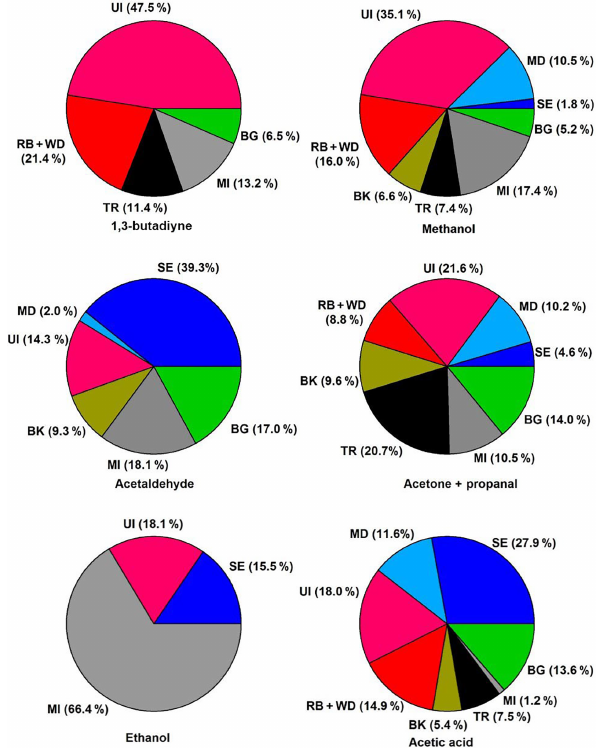
Figure 17. Contribution of PMF-derived sources to 1,3-butadiyne and oxygenated NMVOCs such as methanol, acetone, acetaldehyde, ethanol and acetic acid. Source names are abbreviated as follows: MD is mixed daytime, MI is mixed industrial, UI is unresolved industrial, BK is brick kiln, TR is traffic, RB + WD is residential burning and waste disposal, SE is solvent evaporation, and BG is